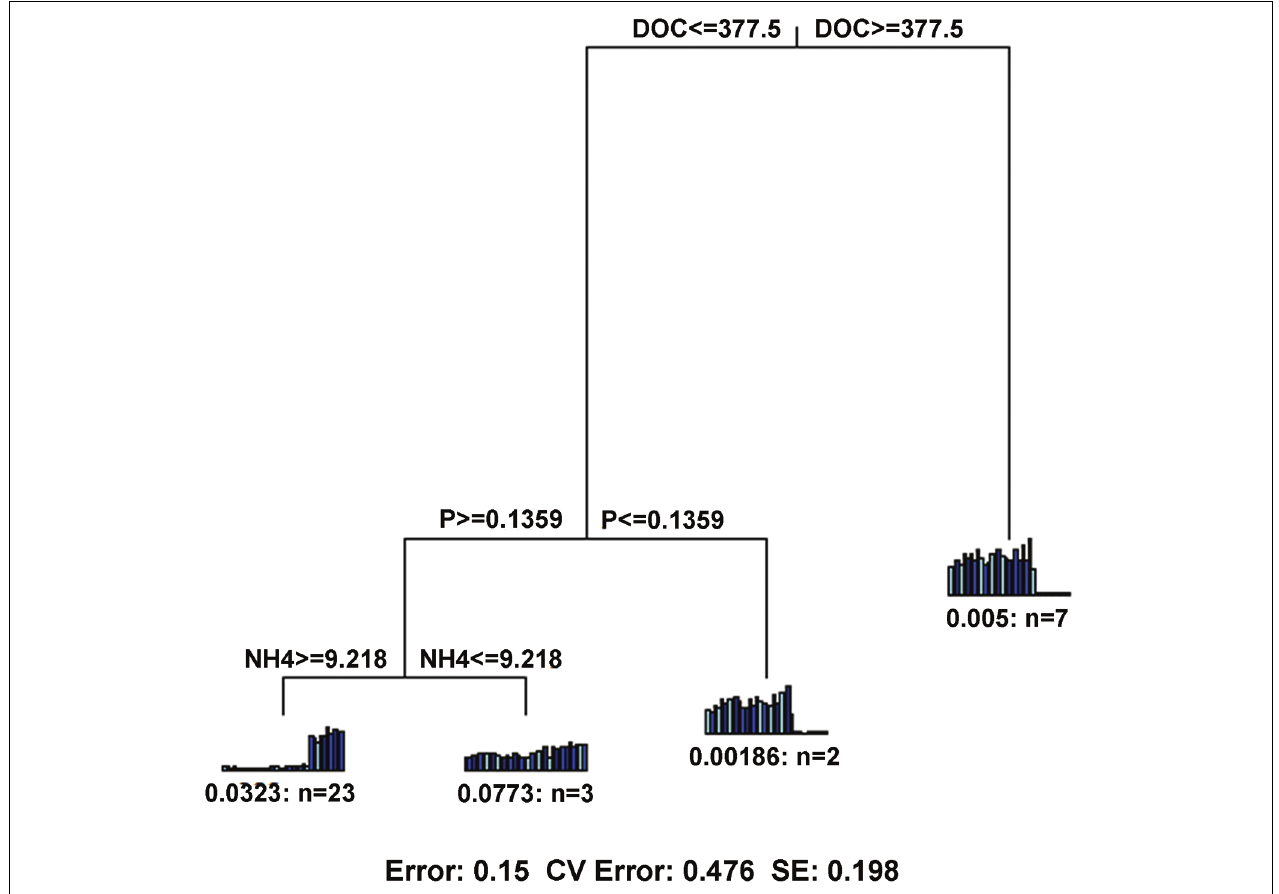
FIGURE 6 | Multivariate regression tree (MRT) showing the most important factor with microbial functional gene composition. DOC, dissolved organic carbon; NH4, ammonium; P, available